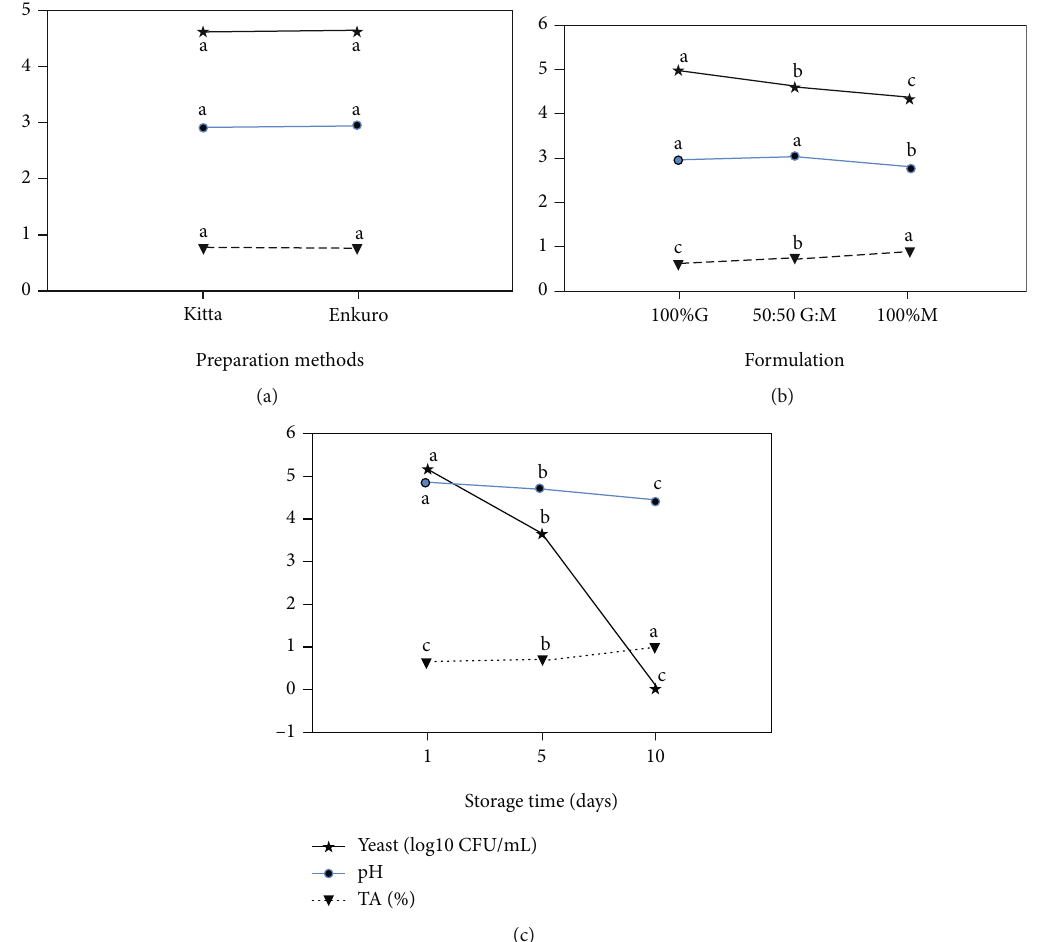
Figure 3: Shelf life of tella for di ff erent preparation methods (a), formulations (b), and storage time (c); TA: titratable acidity; G: gesho ; M: moringa; CFU: colony-forming units; values are least square means with standard errors as error bars and those with di ff erent connecting letters are signi fi cantly di ff erent ( p < 0 : 05